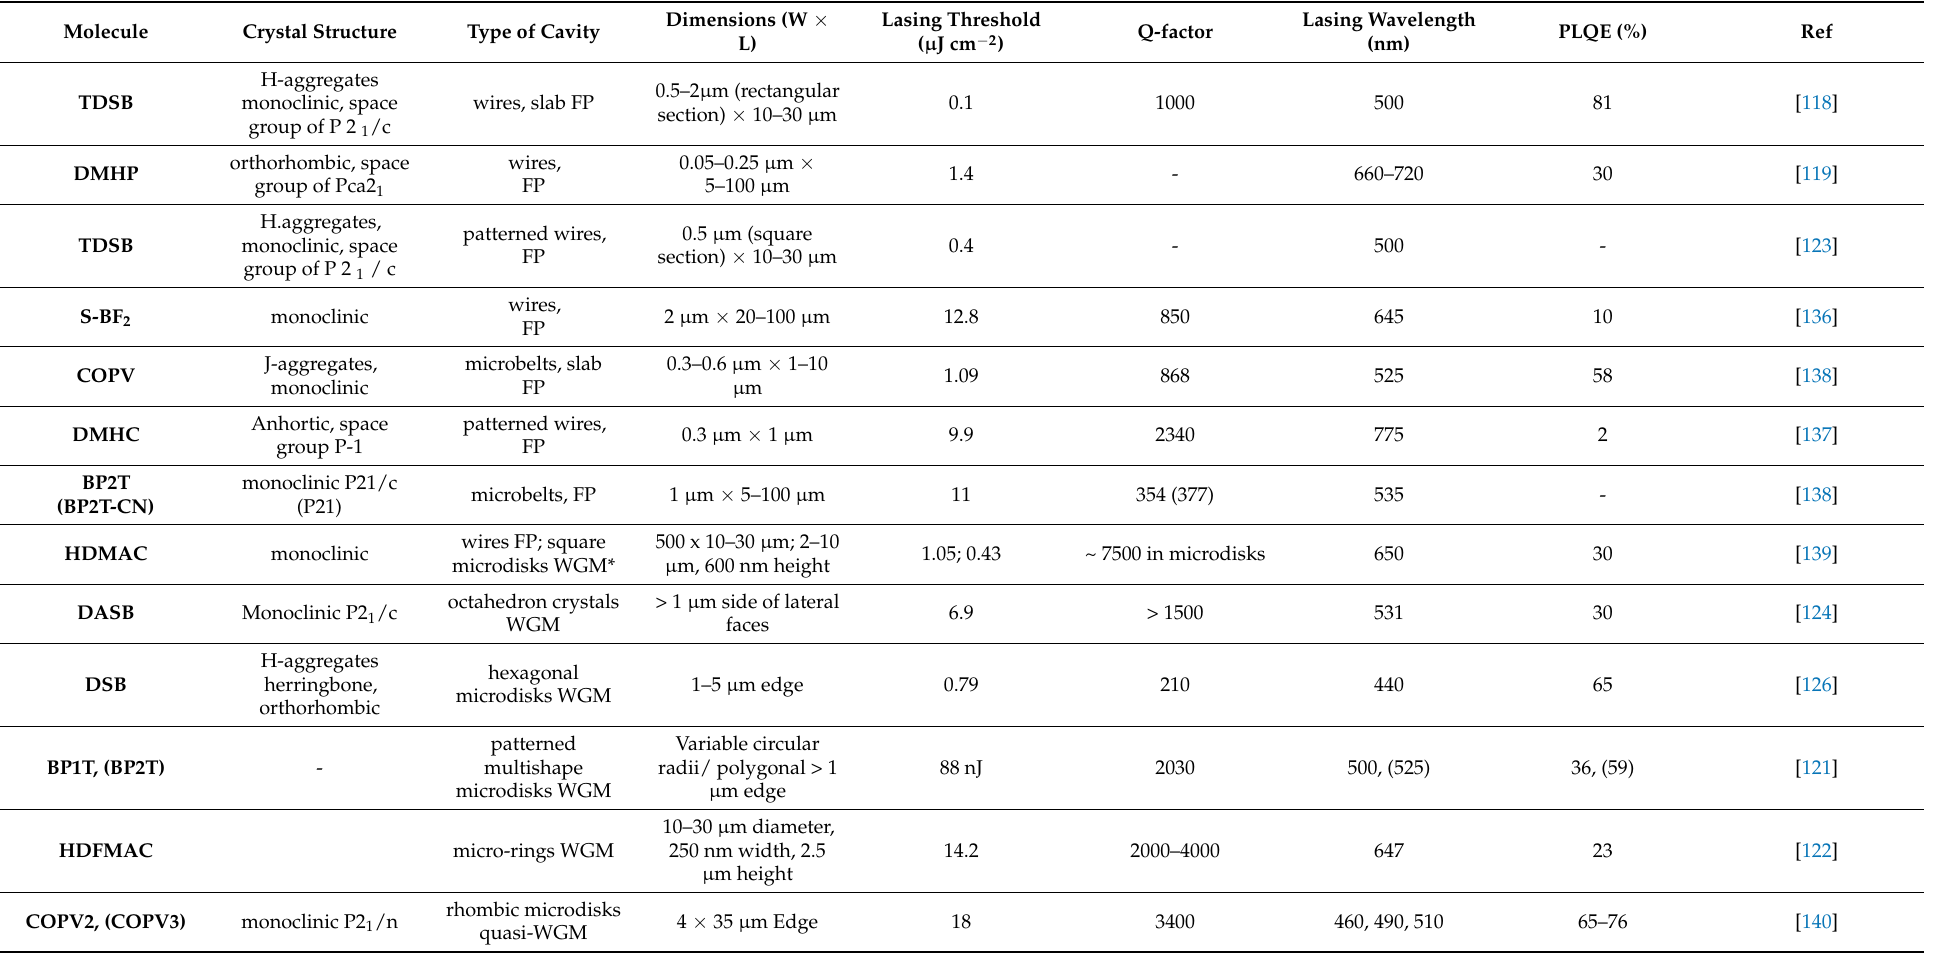
Table 1. Crystallographic and photophysical emission data of organic π -conjugated